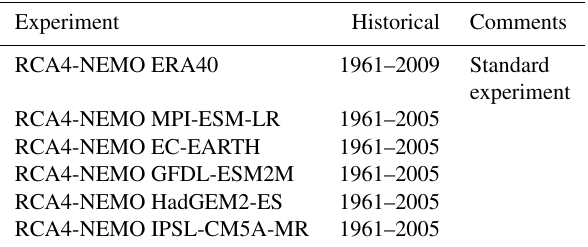
Table 1. Ensemble of regional climate experiments for the North Sea and Baltic Sea region. The table lists the ERA-40 reanalysis and the historical periods of five CMIP5 GCMs that have been down- scaled with